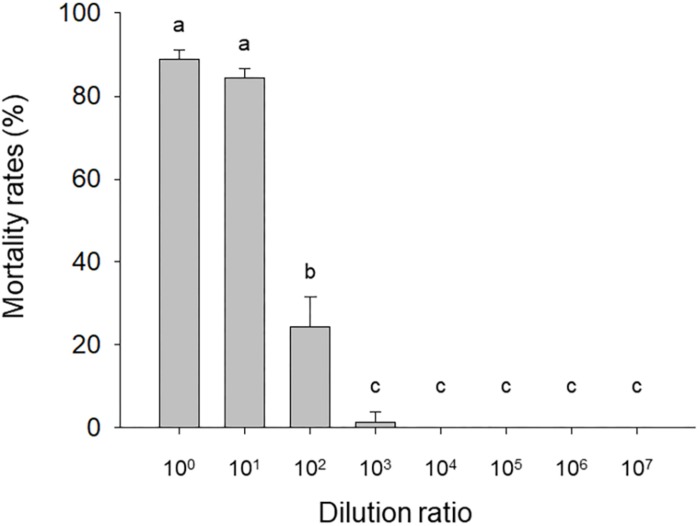
Mortality of needle-inoculated Helicoverpa armigera as affected by HvAV-3i concentration. Third-instar larvae of H. armigera were inoculated (via insertion of a needle into a proleg) with serially diluted hemolymph obtained from Heliothis virescens ascovirus 3i (HvAV-3i)-infected Spodoptera litura larvae (about 1 × 1013 genome copies per mL before dilution). Values are means ± SE of three replications, with 30 larvae per replication. Means with different letters are significantly different (P < 0.05, one-way ANOVA, LSD).